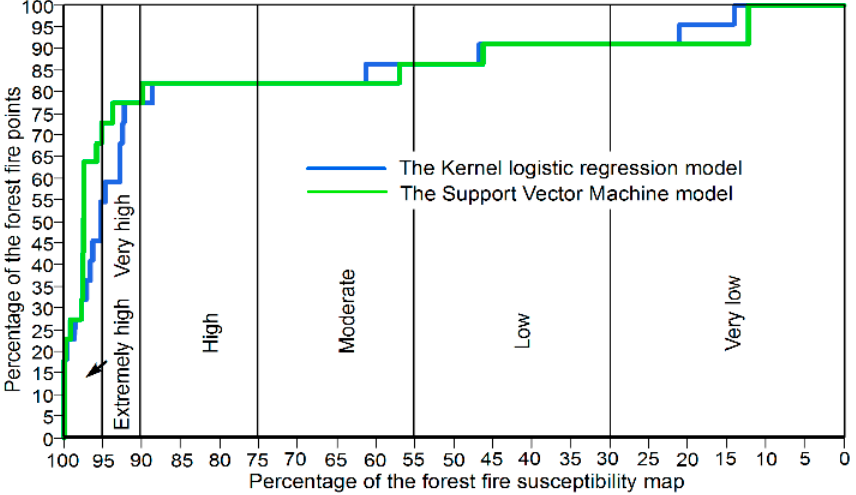
Figure 5. Forest fire susceptibility map for Cat Ba National Park area, Hai Phong City (Vietnam) using the Support Vector Machine model.